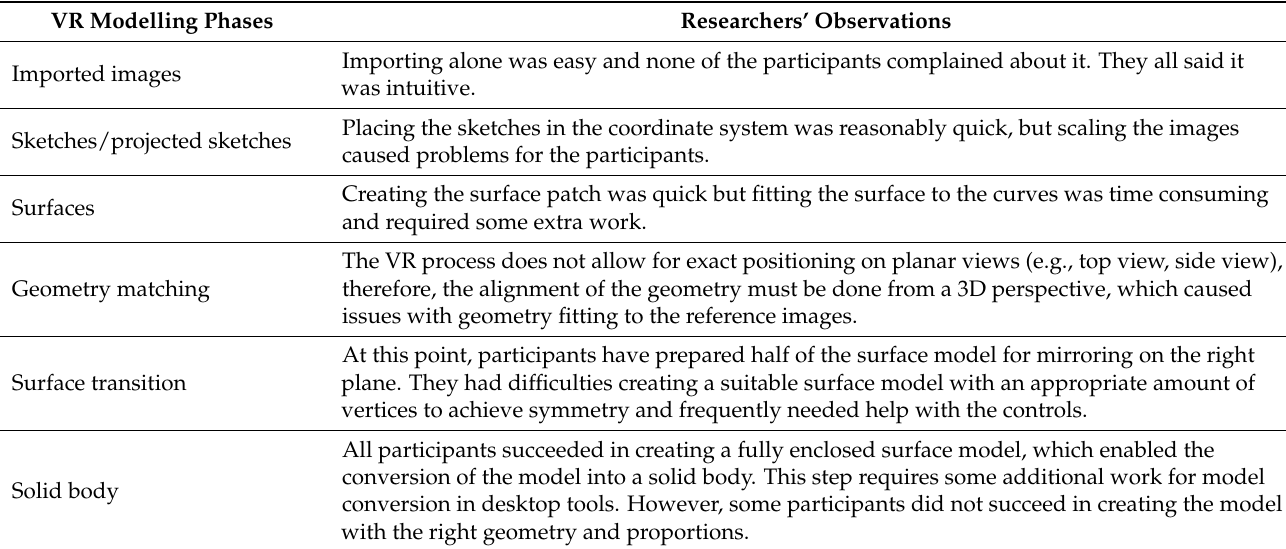
Table 5. Researchers’ observations during the modelling steps.